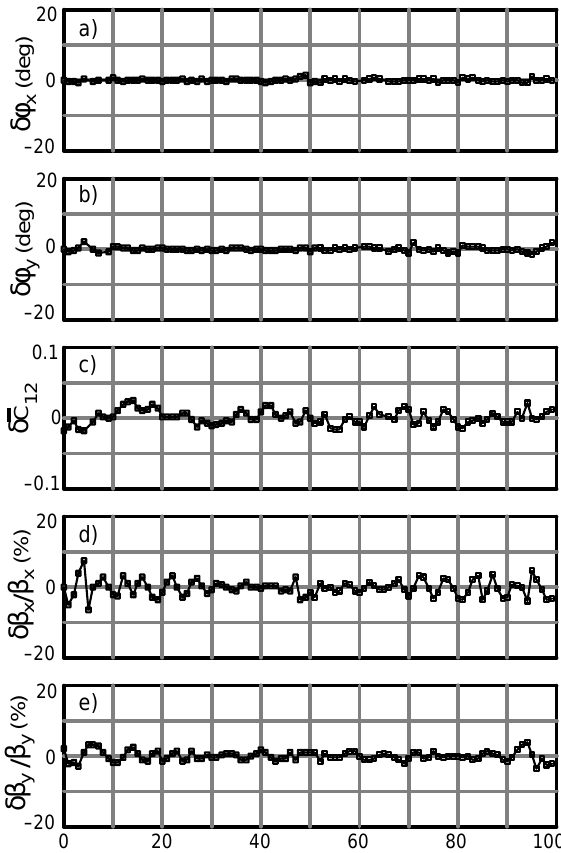
FIG. 5. Initial measurement of phase and coupling before cor- recting. All graphs show the differences between measurement and design. The horizontal scale for the phase and C 12 data is the beam detector index, while for the b data it is the quadrupole index. (a) and (b) horizontal and vertical phase differences. (c) C 12 difference. By design, the design C 12 is zero except within the “coupling bump” near the interaction region which compensates the coupling of the CLEO detector solenoid. (d) and (e) are the b difference.